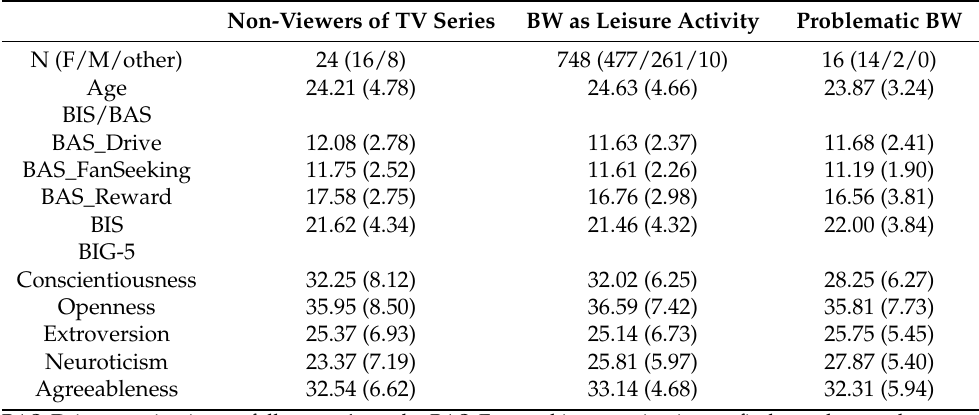
Table 1. Descriptive data of the sample.